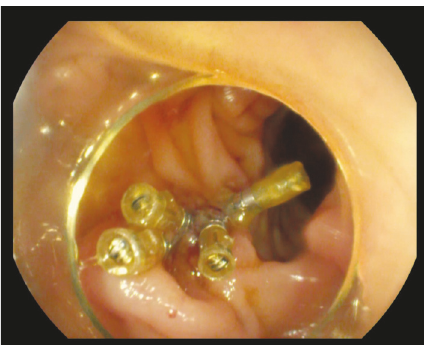
Figure 3: The pigtail drain has been removed and the wall defect has been stapled.